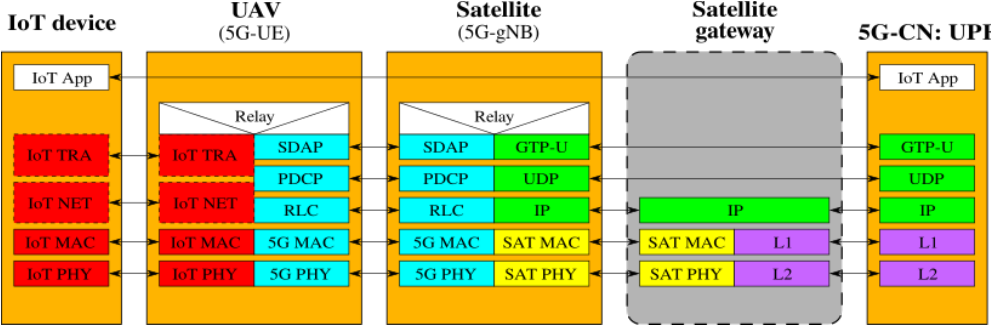
Figure 4. 5G-UE on the UAV and 5G-gNB on the